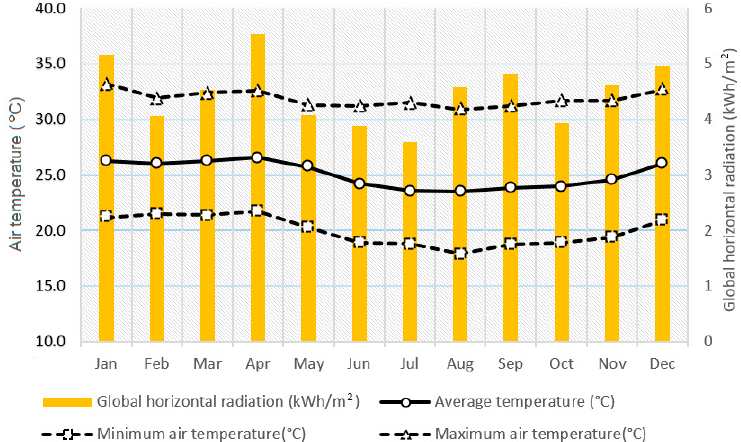
Figure 2. Climate conditions in the Bellavista community (from [18]).